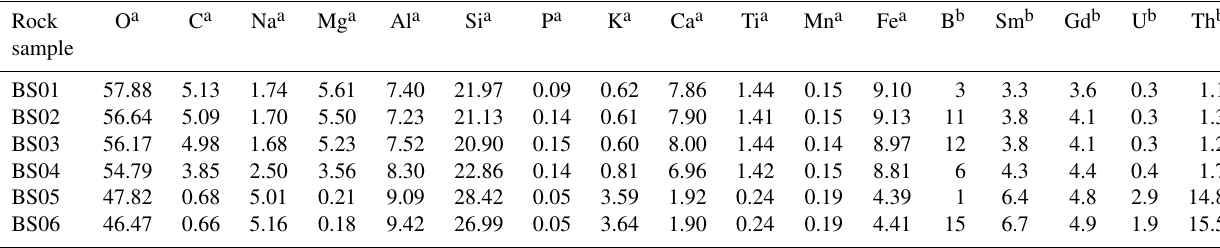
Table C3. Major and trace element data of the six rock samples from the Sanetti Plateau. Rock O a sample